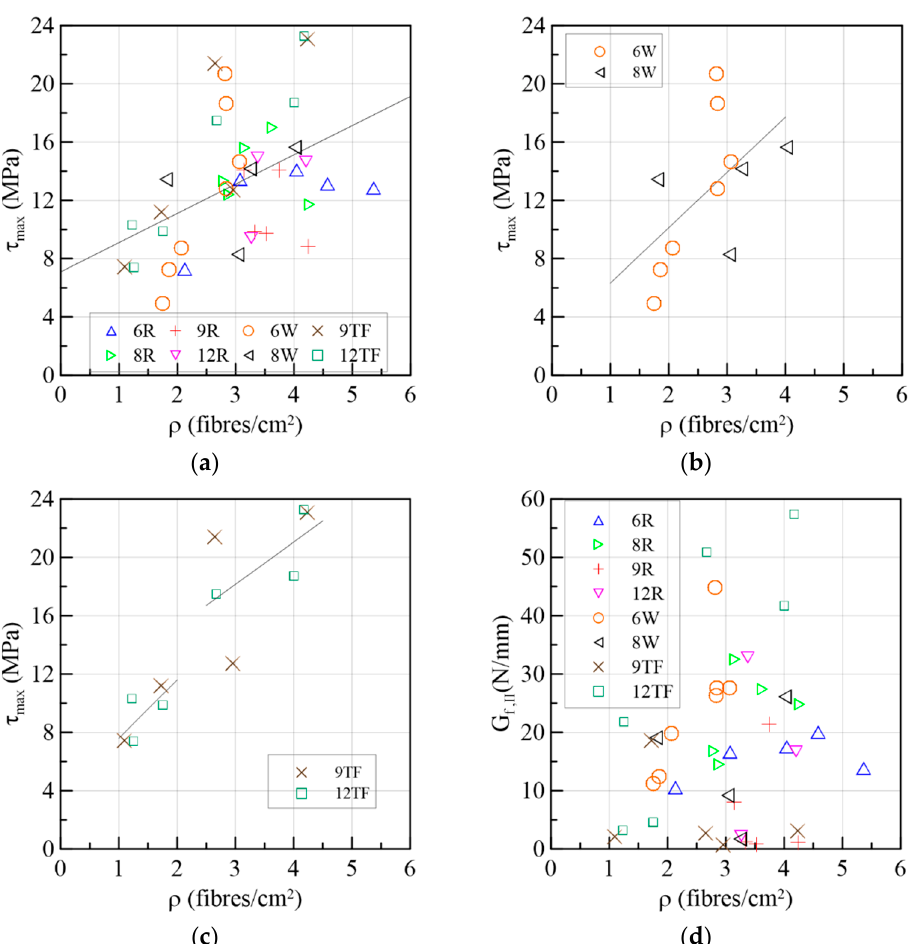
Figure 26. Correlation between fiber density and mechanical parameters: ( a ) shear stress capacity of all prisms; ( b ) shear strength of web specimens; ( c ) shear strength of top flange specimens; and ( d ) Mode-II fracture energy absorbed up to the failure of the